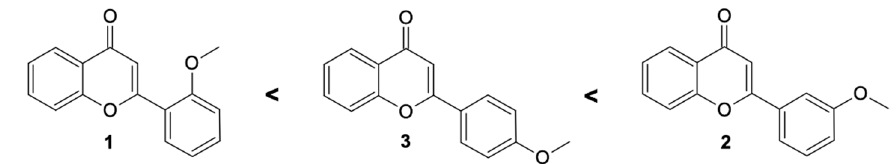
Figure 6. Biotransformation of 4 ′ -methoxyflavone ( 3 ) by B. bassiana KCh